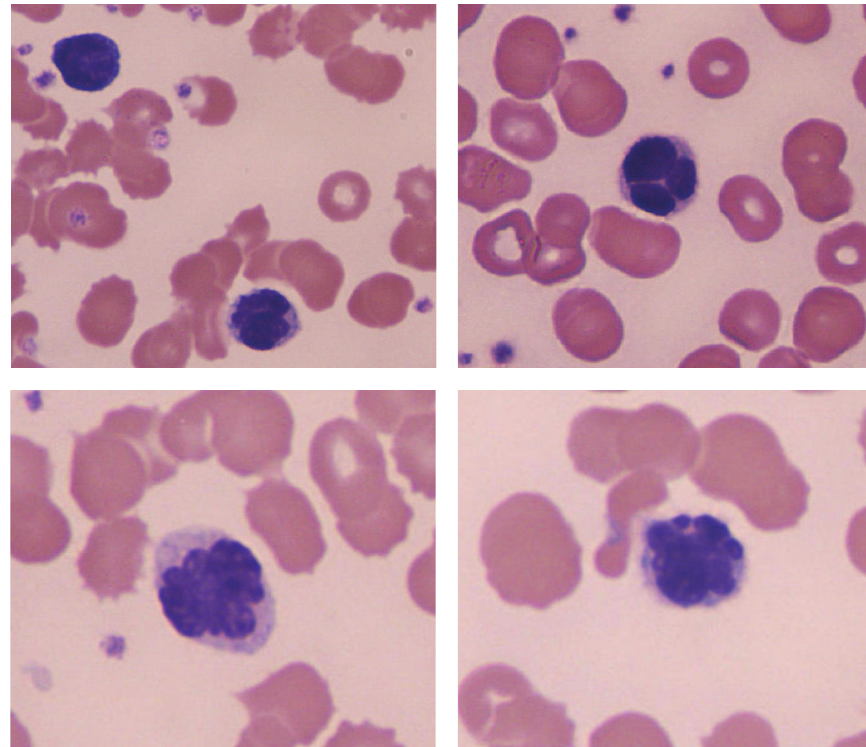
Figure 1: Peripheral blood smear, modified Wrights stain (original magnification × 1000) showing atypical lymphocytes with convoluted